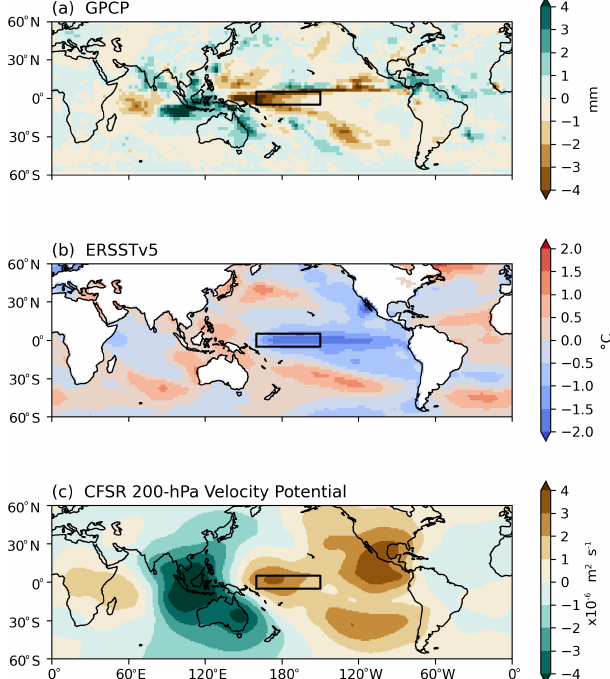
Figure 11. Anomalies of GPCP precipitation, ERSSTv5 SST, and CFSR 200hPa velocity potential during the peak 6 months of the 2010–2011 La Niña event. The box shows the Niño 4 domain in the central Pacific (5 ◦ S–5 ◦ N, 160 ◦ E–150 ◦